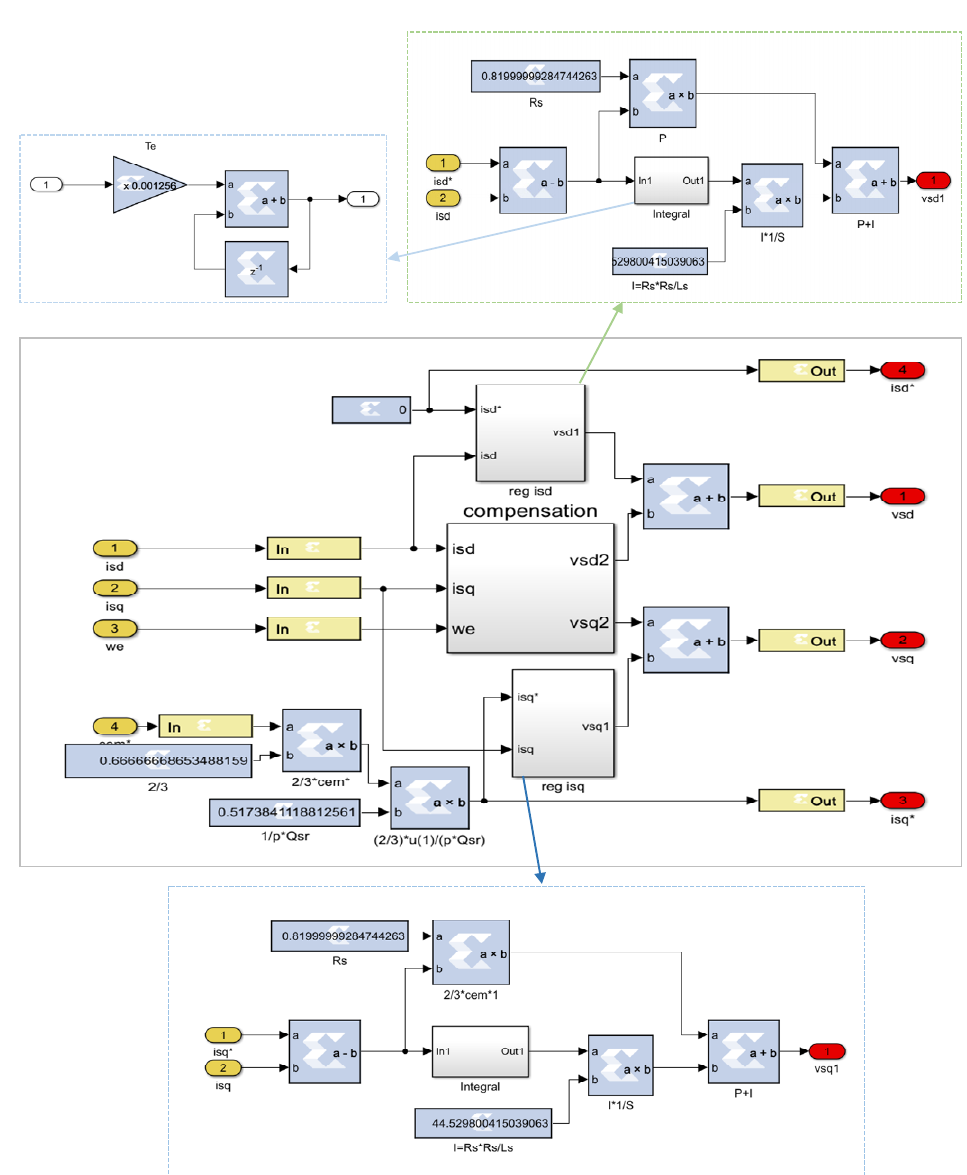
Figure 12. Hardware design of VCS-PI controllers for PMSG-side converter. Where (*) is added to distinguish between the actual and the references variables.